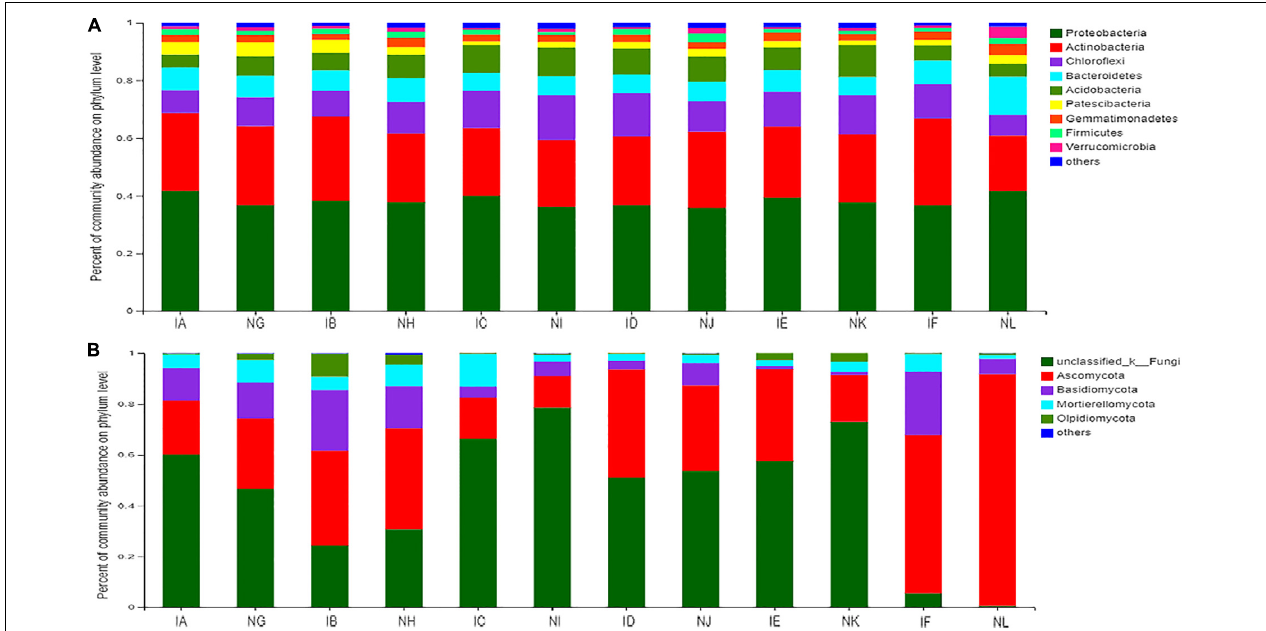
FIGURE 3 | (A) Comparison of taxonomic distributions of bacterial phyla between different concentrations of difenoconazole fungicide in T. controversa- infected and non-infected samples. IA ( T. controversa + 1.5% dose of difenoconazole), NG (control + 1.5% dose of difenoconazole), IB ( T. controversa + 3% dose of difenoconazole), NH (control + 3% dose of difenoconazole), IC ( T. controversa + 5% dose of difenoconazole), NI (control + 5% dose of difenoconazole), ID ( T. controversa + recommended dose of difenoconazole), NJ (control + recommended dose of difenoconazole), IE ( T. controversa + 1. 5 times dose of difenoconazole), NK (control + 1. 5 times dose of difenoconazole), IF ( T. controversa + no difenoconazole), and NL (control + no difenoconazole). The control indicates treatment with ddH 2 O. (B) Comparison of taxonomic distributions of fungal phyla between different concentrations of difenoconazole fungicide